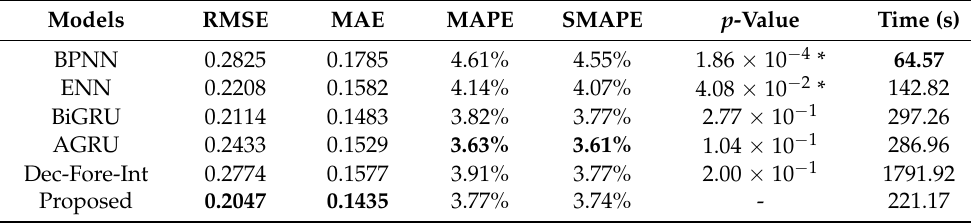
Table 6. Average accuracies of different hybrid neural network